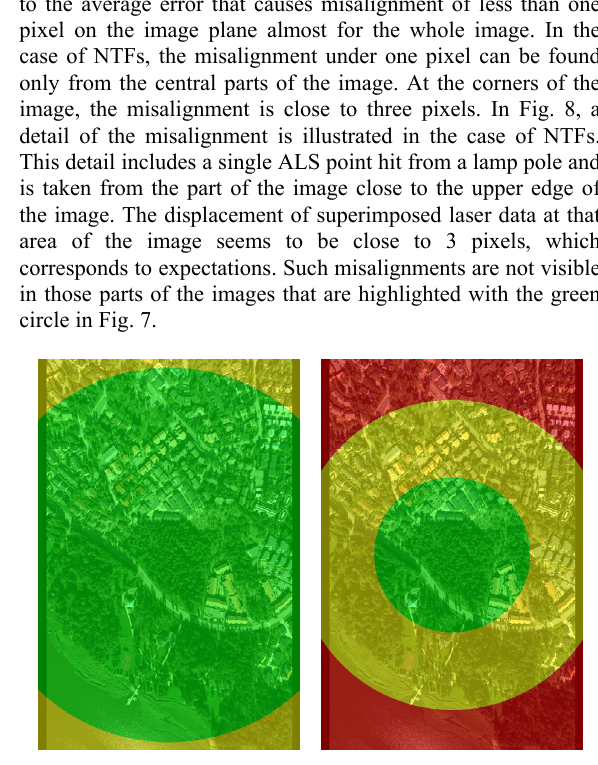
Figure 7. Expected misalignment on the image plane after the registration due the detected average height error. In green areas misalignment is under one pixel, in yellow areas less than two pixels and in red areas under three pixels. The left image visualises the average height error of -0.36 m and the right image the average height error of 0.87 m.